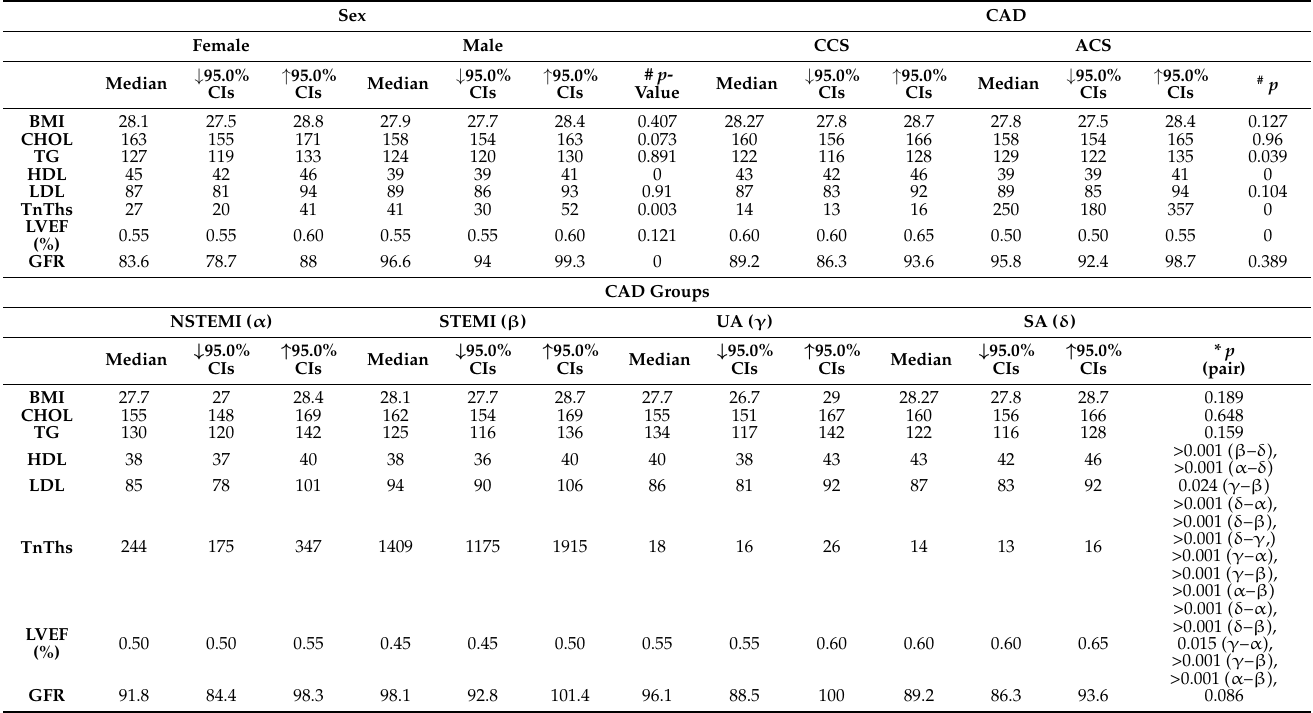
Table 2. Baseline biochemical characteristics of the studied